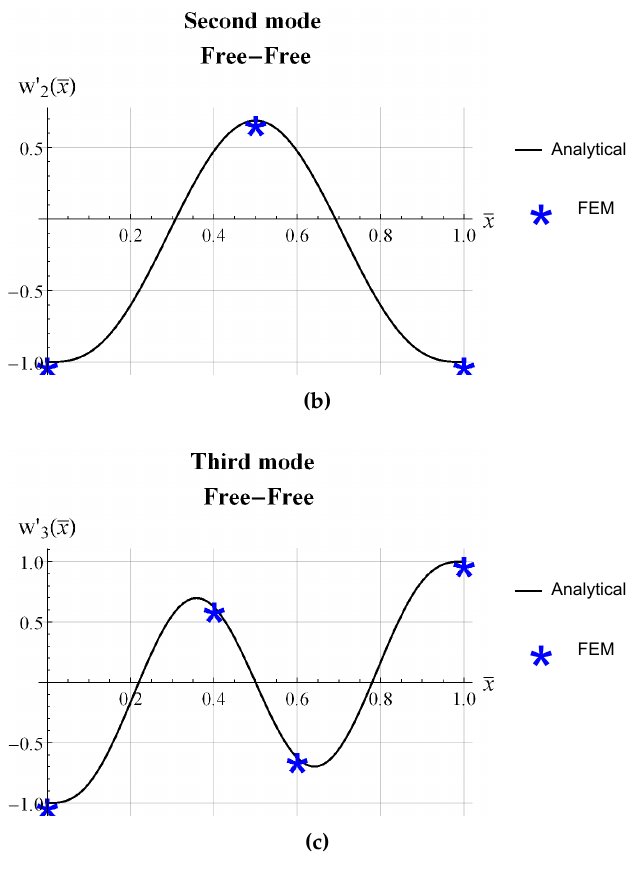
Figure 5. First derivatives of the first three modes for free-free boundary condition: ( a ) first mode, ( b ) second mode, and ( c ) third mode. The FEM results highlight the optimal location of the voltage sign switch (illustrated with blue stars).